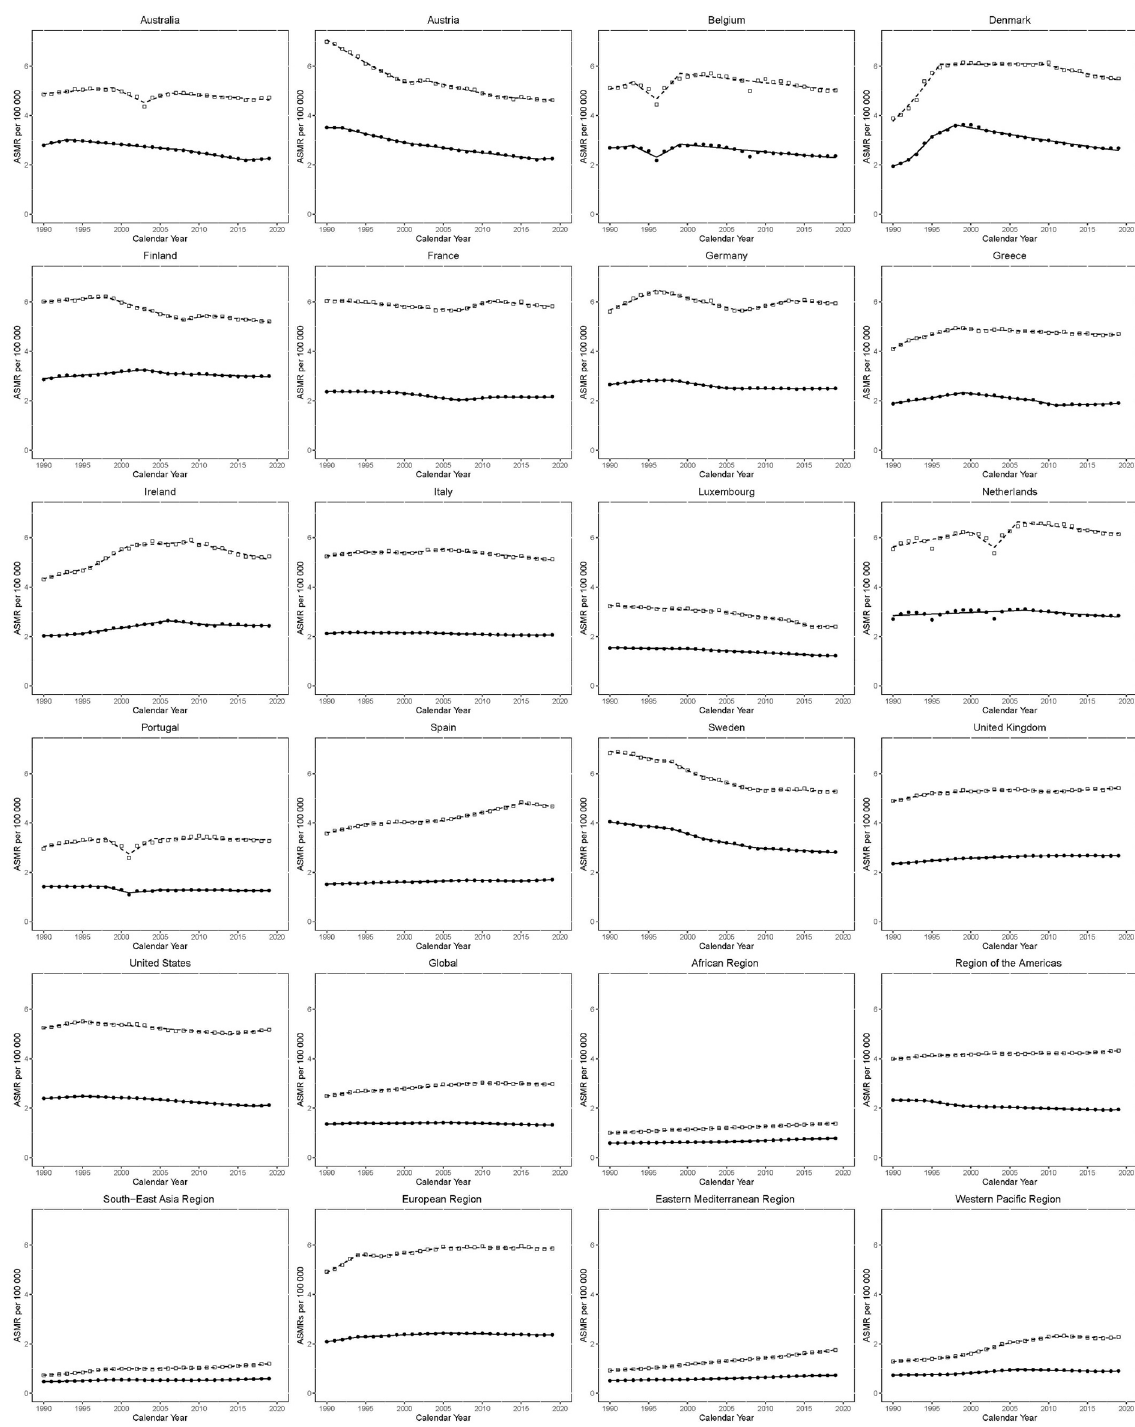
Figure 4. Trends in age-standardized mortality rates (ASMR) per 100,000 for KC in EU15 + countries and WHO regions between 1990 and 2019. Open squares indicate males; and filled circles,